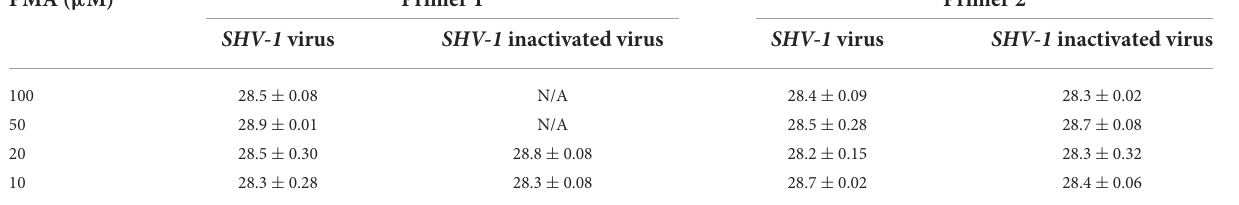
TABLE 4 Two primers to determine the working PMA